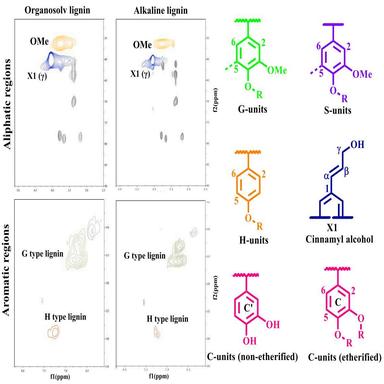
2 D NMR analysis of organosolv and alkaline lignin extracted from CSHs.